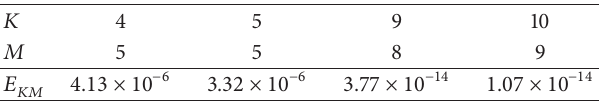
Table 10: The maximum errors of 𝐸 𝐾𝑀 for different values of 𝐾 and 𝑀